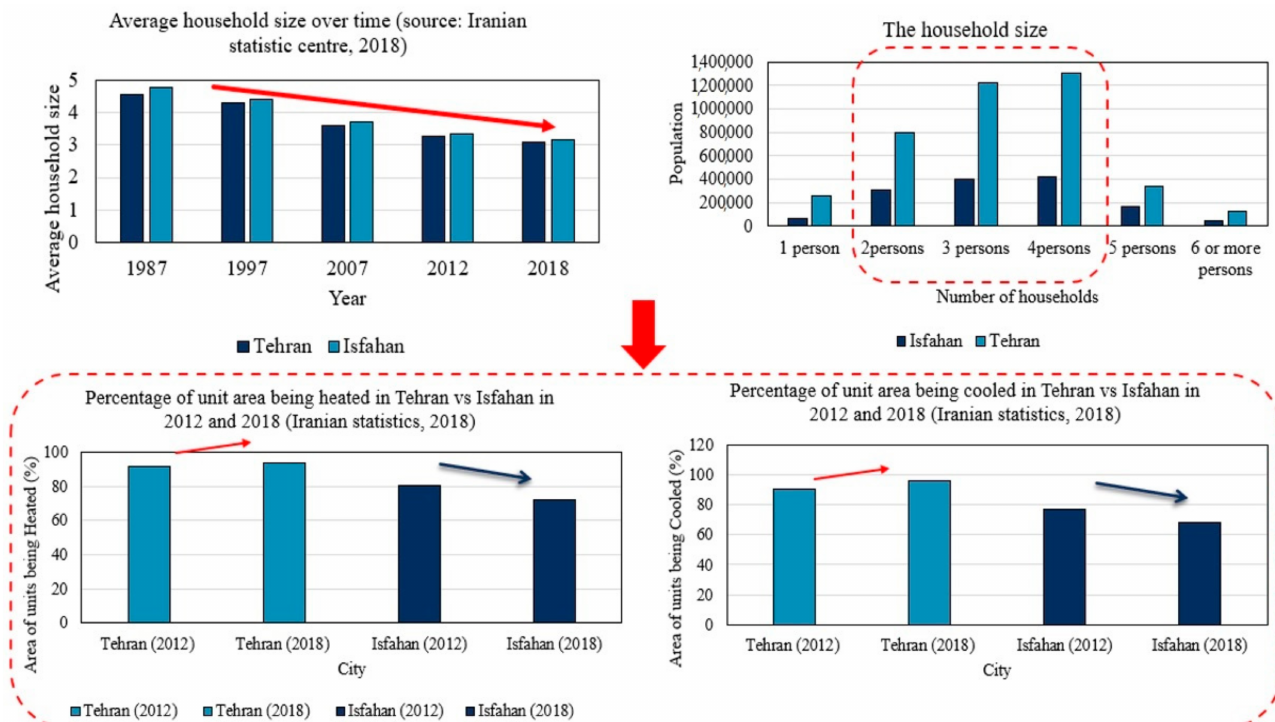
Figure 27. The effect of household size on electricity consumption in Tehran compared to Isfahan. The comparative analysis between Tehran and other provinces revealed that in ad- dition to climatic reasons, behavioural factors, namely house size, heated or cooled area percentage of space, and household size, could play a crucial role in increasing the amount of electricity used per